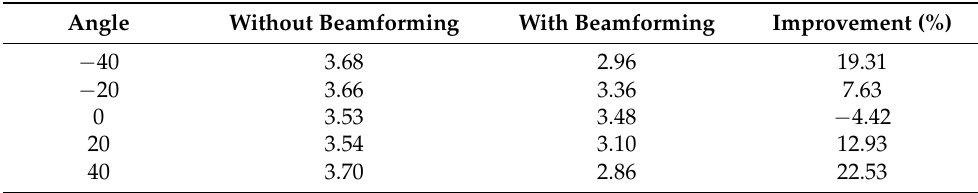
Table 9. The MAE of HR at five different angles. Individual MAE at all three distances (0.9, 1.2 and 1.5 m) are combined at each angle.